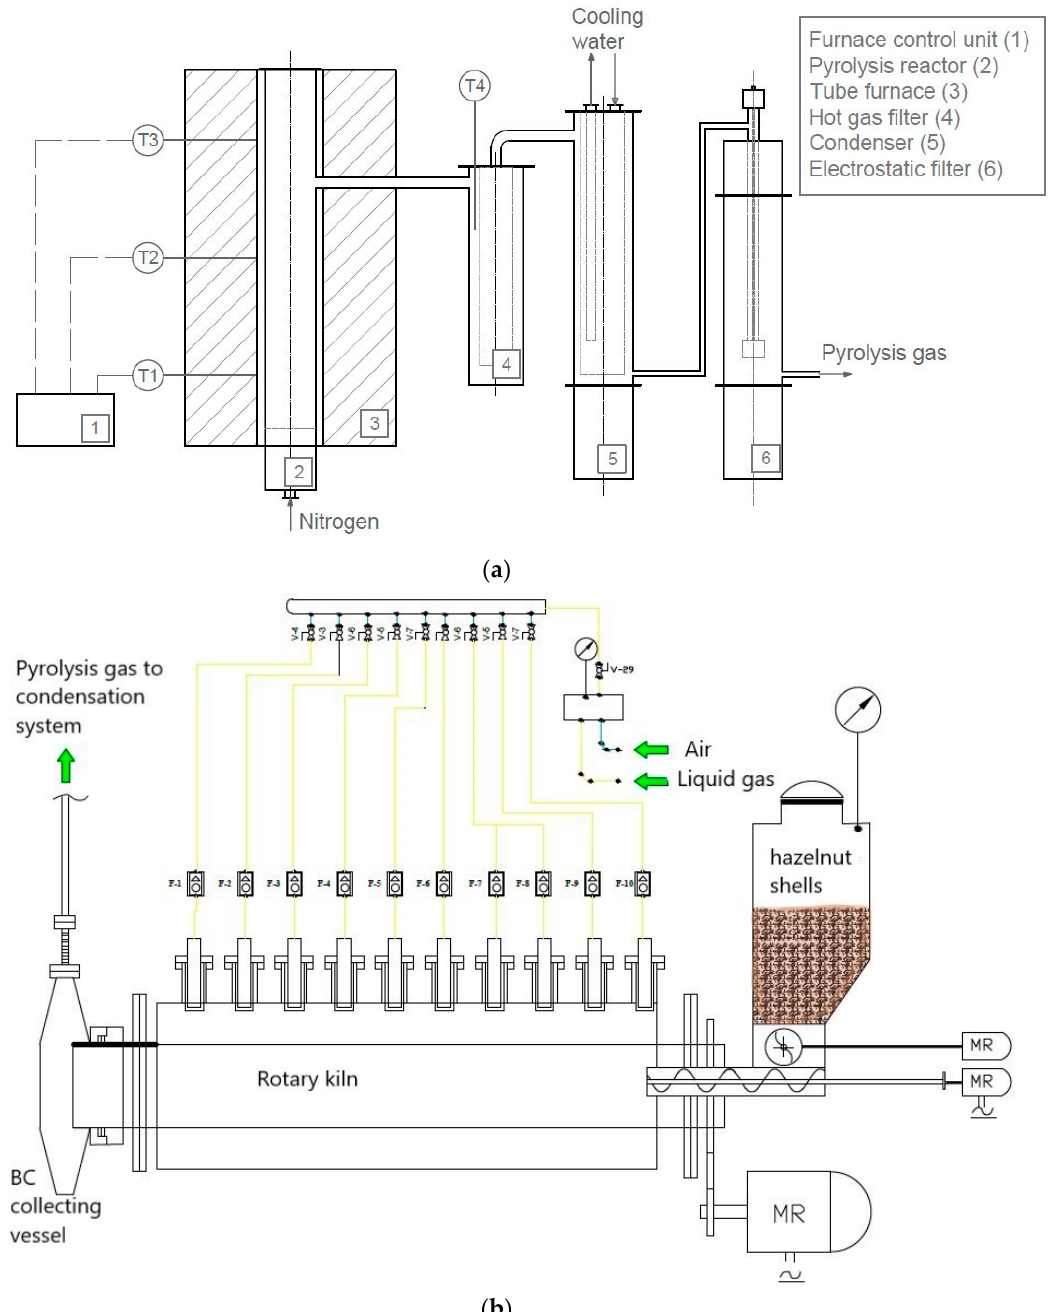
Figure 1. ( a ) Schematic sketch of the fixed bed reactor used for the pyrolysis of hazelnut shells (top); ( b ) schematic sketch of the rotary kiln used for the pyrolysis of hazelnut shells (MR...gear motor, F i ...flowmeter, V i …valve) (bottom).